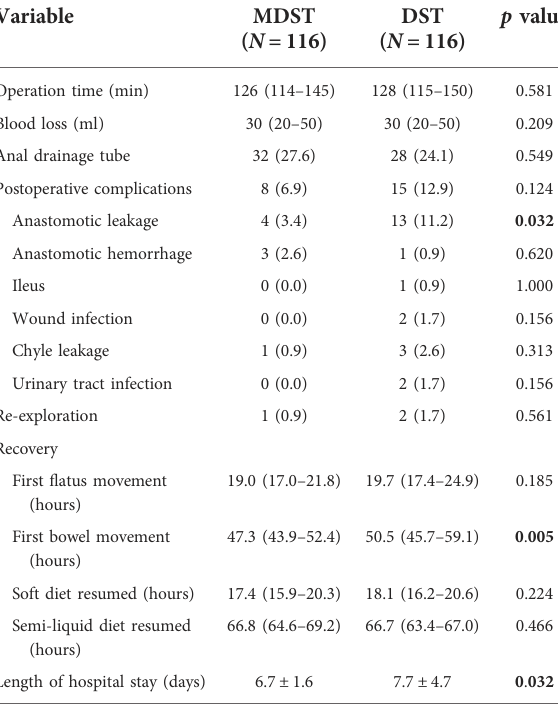
TABLE 2 Comparison of perioperative outcomes and postoperative